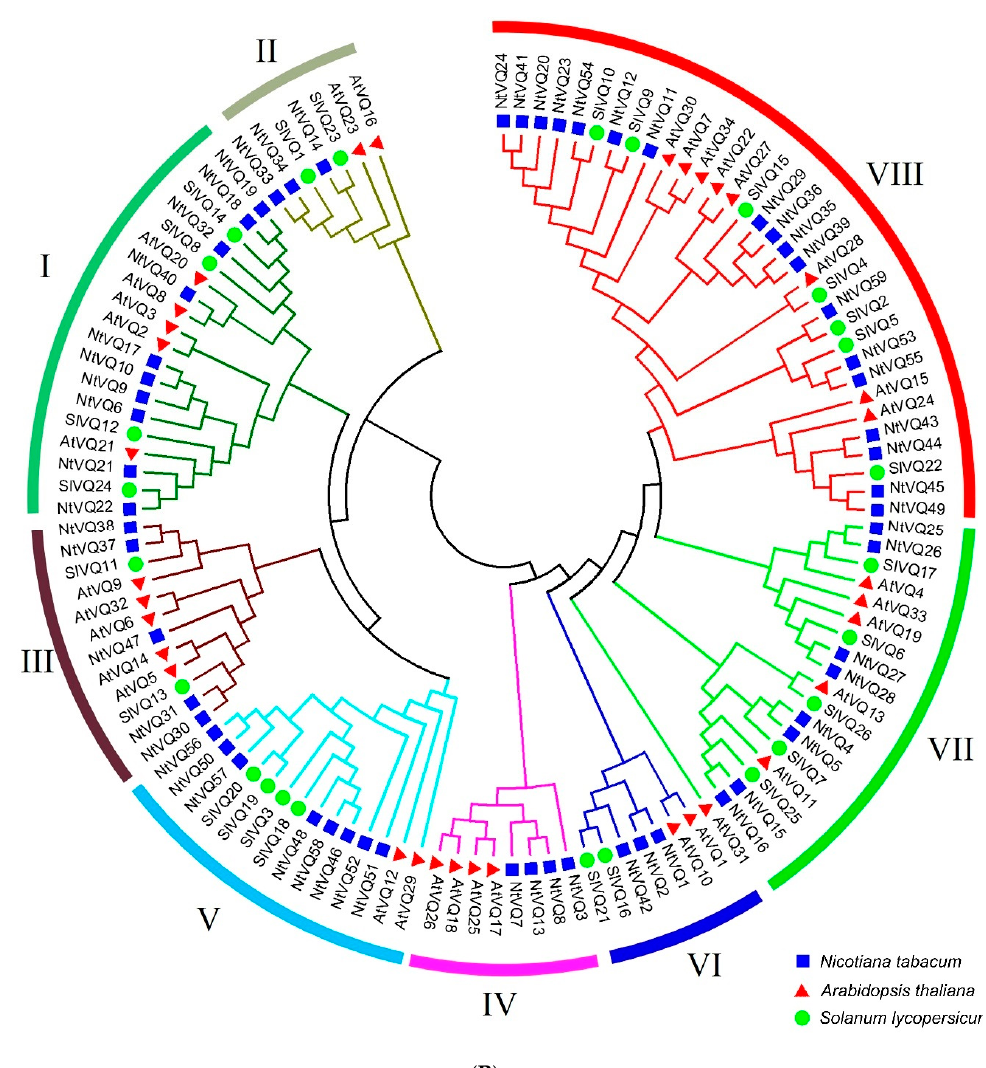
Figure 1. Phylogenetic tree of VQ motif-containing proteins (VQ proteins) using Maximum Likelihood method. ( A ) Phylogenetic tree and clustering of Nicotiana tabacum L VQ motif-containing (NtVQ) proteins in tobacco. Shown along the genes are indications of major responses to various phytohormonal and abiotic stresses. Phytohormone-responsive genes are indicated with small circles in different colors. Wounding-responsive and temperature-related genes are illustrated with a thermometer and scissors symbol, respectively. The Roman numerals I–VIII stand for separated groups in the phylogenetic tree. ( B ) Phylogenetic analysis of NtVQ proteins from tobacco, Arabidopsis and tomato. The sequences of VQ proteins in Arabidopsis and tomato were downloaded from Phytozome (https://phytozome.jgi.doe.gov/pz/portal.html, v12.1). The names of Arabidopsis and tomato VQ proteins were in line with those previously published. The phylogenetic tree of 59 tobacco NtVQs, 34 Arabidopsis AtVQs and 26 tomato SlVQs was made by Mega 7.0 using Maximum Likelihood method. Based on the clustering of the VQ proteins, tobacco NtVQs were clustered into eight subgroups (I–VIII). Proteins from tobacco, Arabidopsis and tomato are denoted by blue squares, red triangles and green circles.